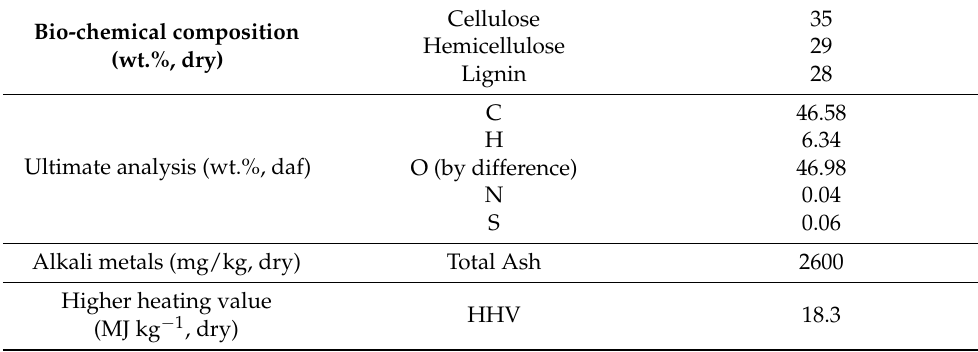
Table 4. Feedstock composition from Westerhof et al. [29].